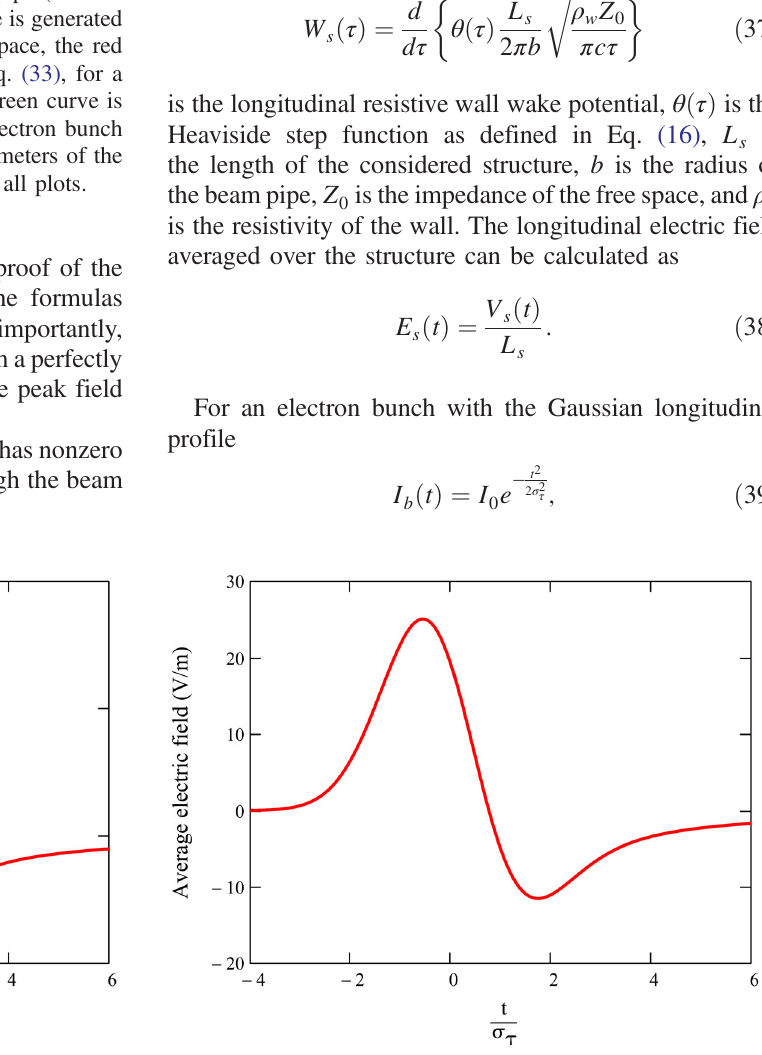
FIG. 11. Average longitudinal electric field due to longitudinal resistive wall impedance for the CeC proof of principle experiment (left) and the proposed eRHIC CeC parameters (right). The following parameters are applied in generating the plots: ρ 6 . 9 × 10 − 7 Ω m and b ¼ 2 . 54 cm. It is worth noting that the bunch head is at negative t , i.e. towards the left of the